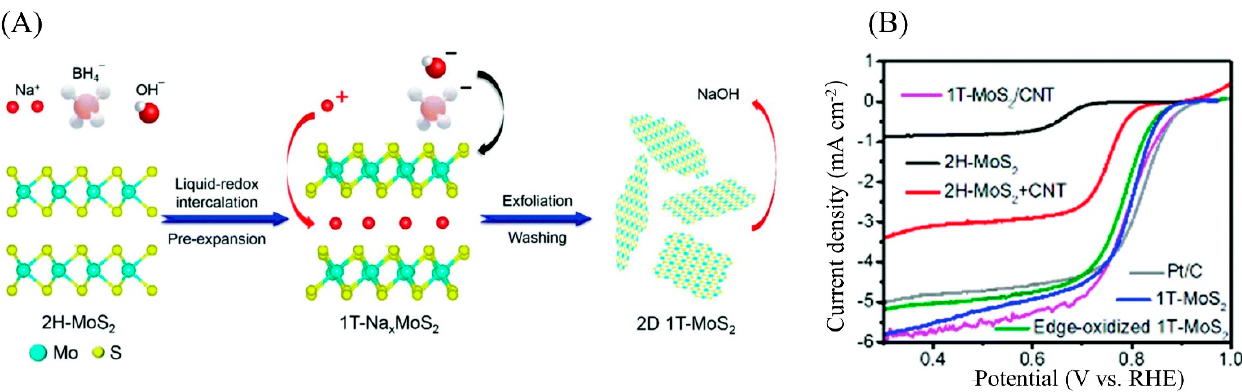
Figure 11. ( A ) Illustration of the synthetic procedure. ( B ) Electrocatalytic activities of 1T-MoS 2 , 1T-Na x MoS 2 , 1T-MoS 2 /carbon nanotube (CNT), 2H-MoS 2 , 2H-MoS 2 /CNT, and Pt/C in O 2 -saturated 0.1 M KOH. Reproduced with permission from [101]. Copyright © 2021 The Royal Society of Chemistry.